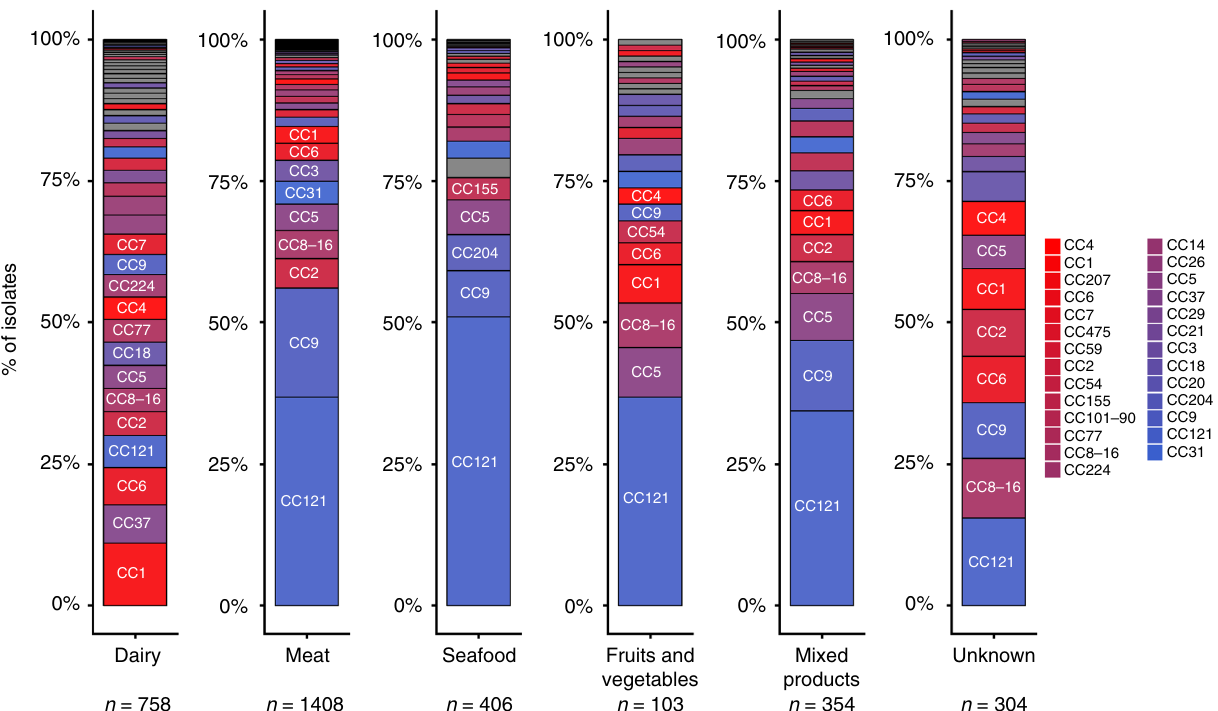
Fig. 3 CC proportions in different food categories. The 3333 food isolates included in the study are represented. Percentage of isolates of each CC per food type (dairy products, meat products, seafood, fruits and vegetables, mixed products, and unknown food types) are represented. Major CCs representing individually at least 0.5% of all the isolates of the study are shown with similar colors than in Fig. 1a. The other CCs, considered as minor, are represented in gray. Clones relevant for interpretation are indicated on the graphs. Number of isolates from each food type are indicated below the